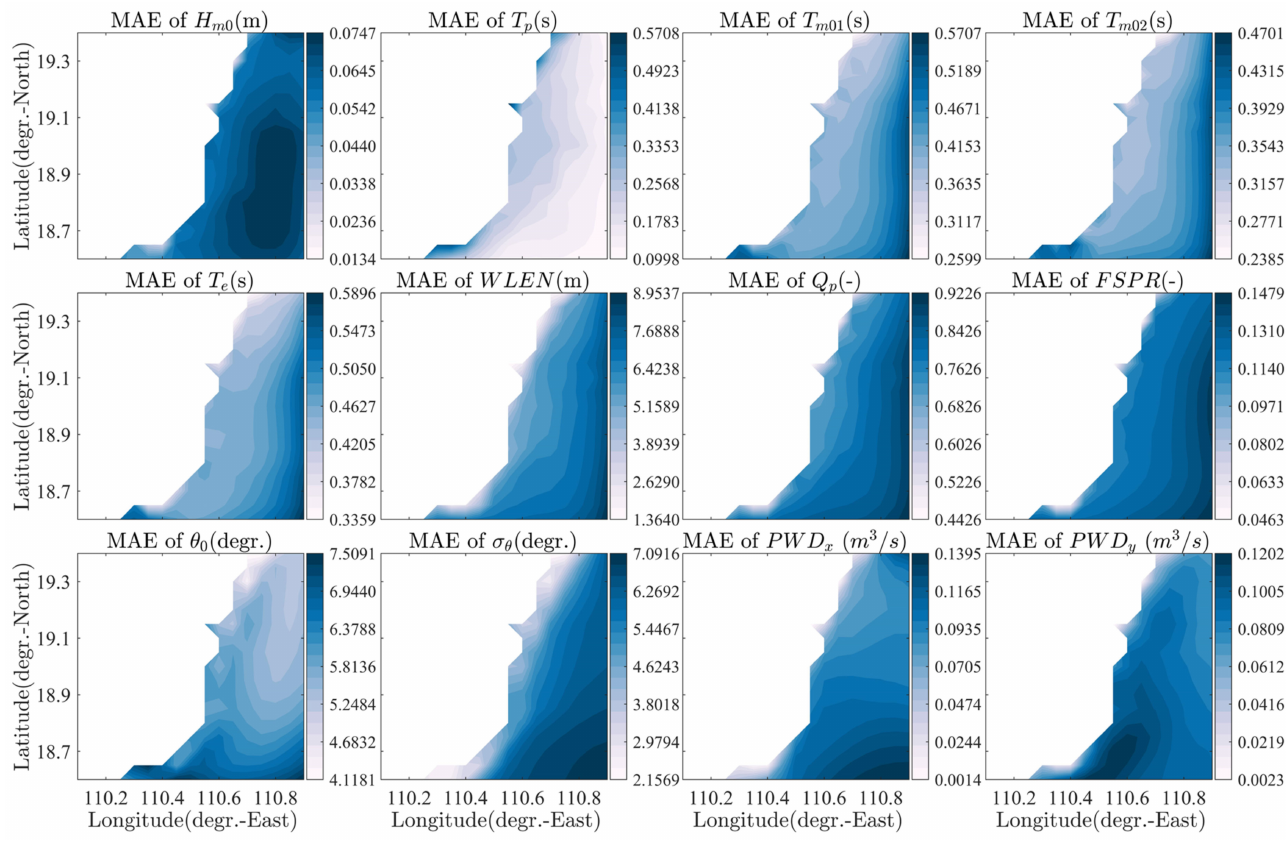
Figure 12. Spatial distributions of MAE of the KPs derived from the SWAN BLOCK outputs simulated with the original and the TMA–Mitsuyasu reconstructed boundaries. In each panel, the values of MAE are indicated by the colors, the title identifies the corresponding KP, and the x and y axes denote the longitude ( ◦ E) and latitude ( ◦ N), respectively. Table 5. Correlation coefficient (R) of the KPs derived from the original and the reconstructed (obtained under different strategies of n fr and n tl ) partitions at check point B2. The R values were derived from all the partitions identified, and the values illustrated under the other n fr and n tl combinations are relative to those obtained under the setting of n fr = 3 and n tl =